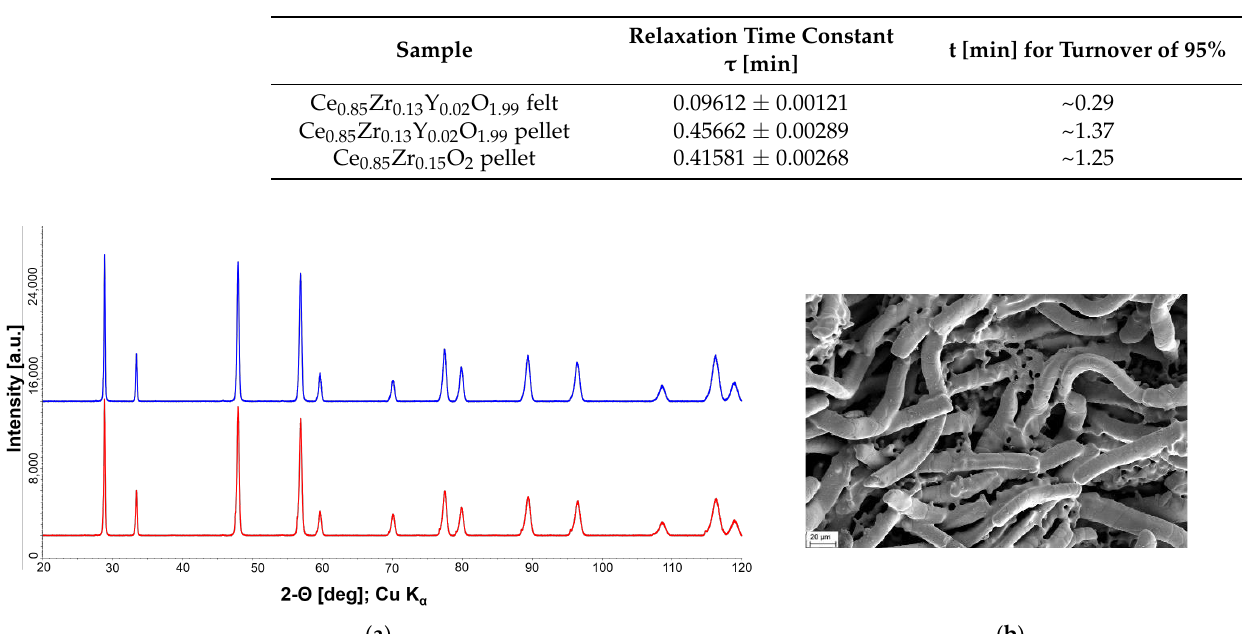
Table 1. Calculated relaxation time constants and reaction times for a turnover of 95% based on the fit of the mass curves in Figure 13 using Equation (4).